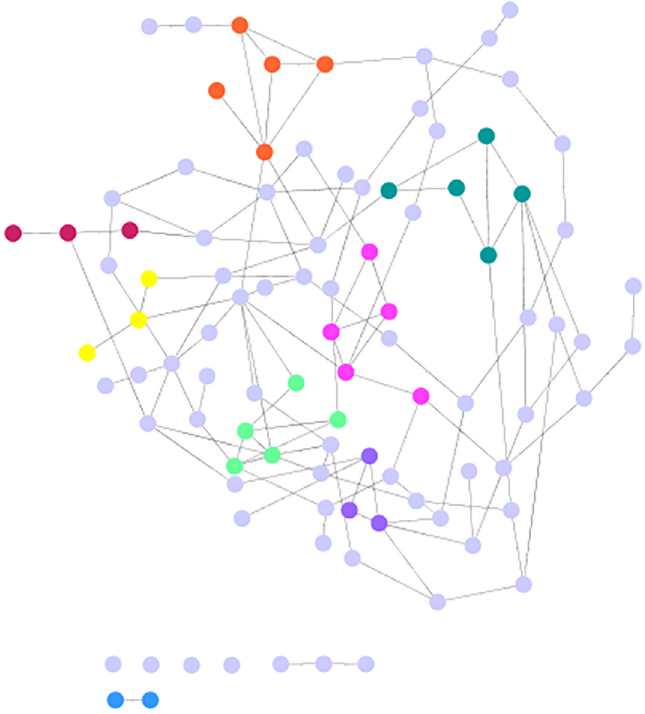
Fig 7. The CHIDS Causal Network After Random Node Removal. The CHIDS network after the sequential removal of 15 nodes at